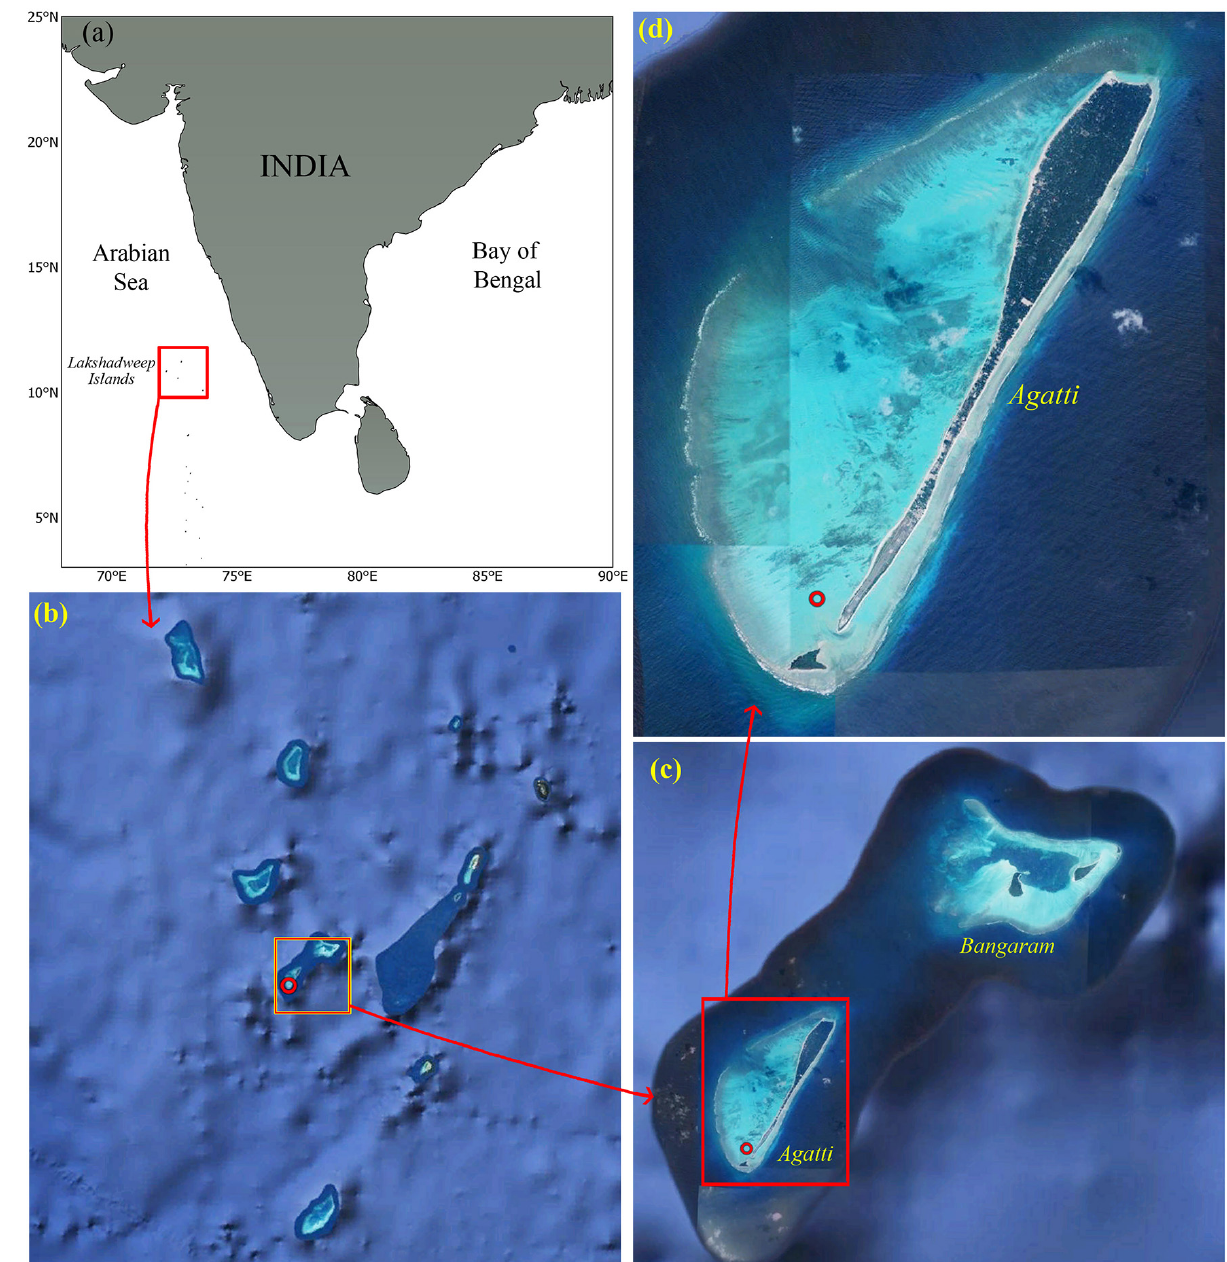
Figure 1. Map showing ( a–d ) location of Agatti Island, Lakshadweep, India, the type locality of Actinimenes koyas sp.